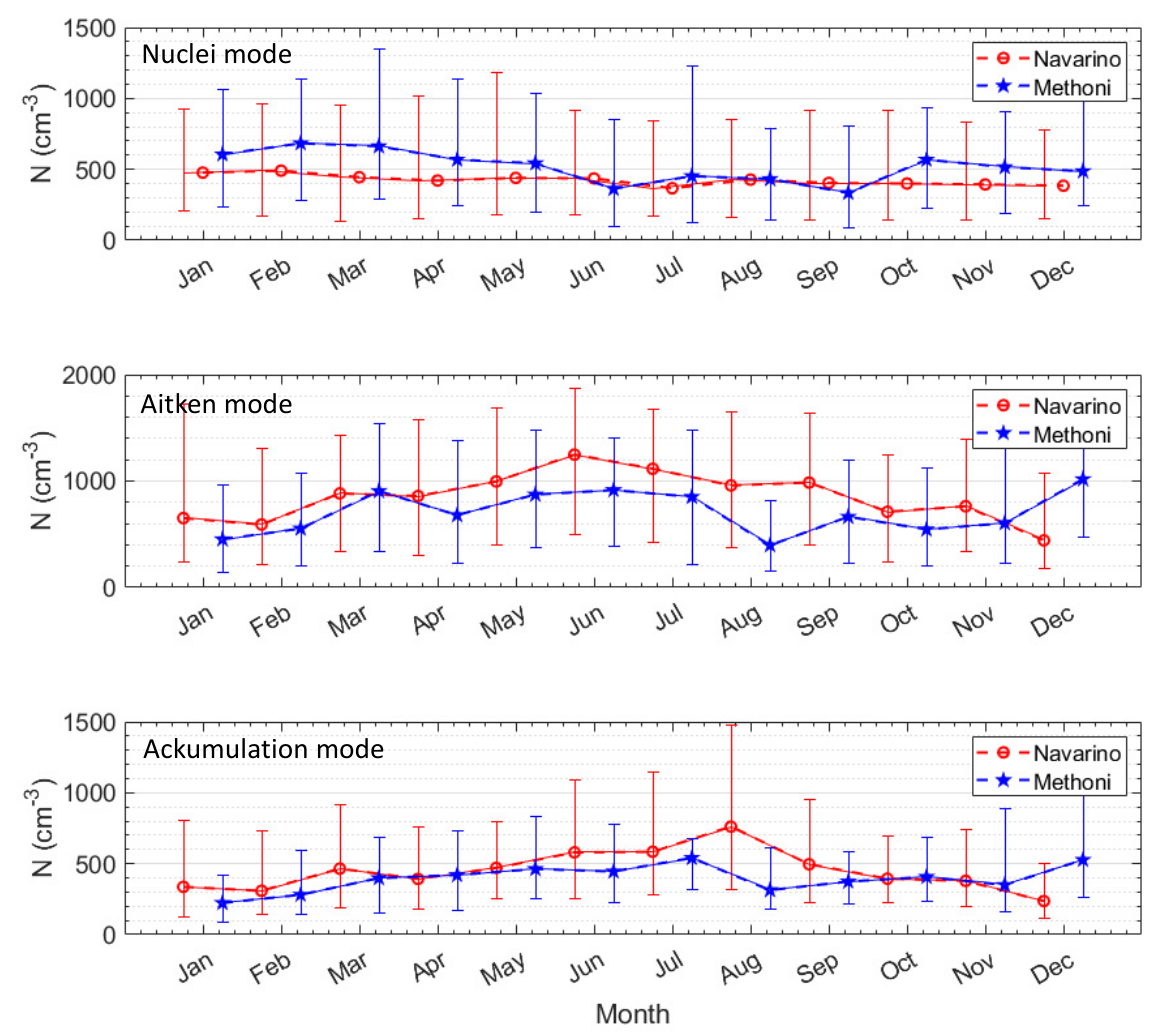
Figure 10. Monthly particle number in the different modes of all measurements between 9 and 15 UTC measured at Navarino and Methoni. The dotted curves indicate the median values while the error bars indicate the inter-quartile range.